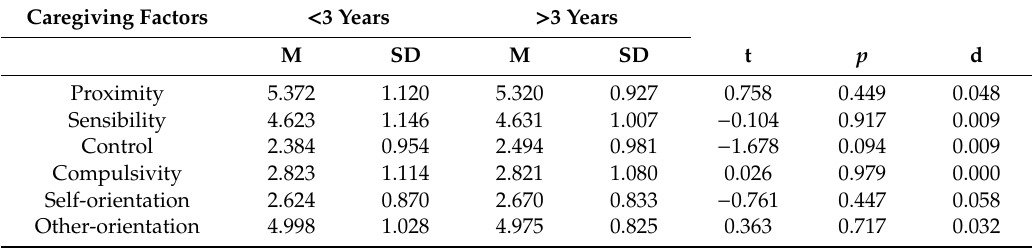
Table A2. Comparison in CQ dimensions according to relationship length (median).